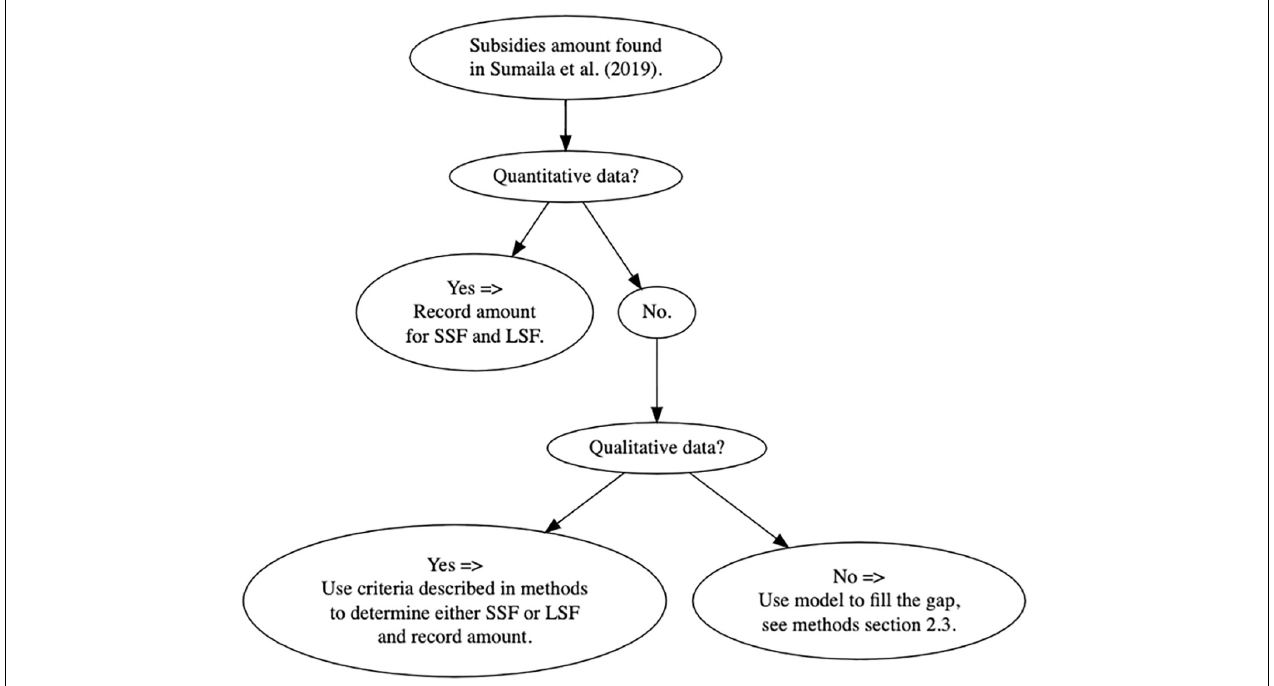
FIGURE 1 | Methodology used to split 2018 subsidy amounts into small- (SSF) and large-scale fisheries (LSF).